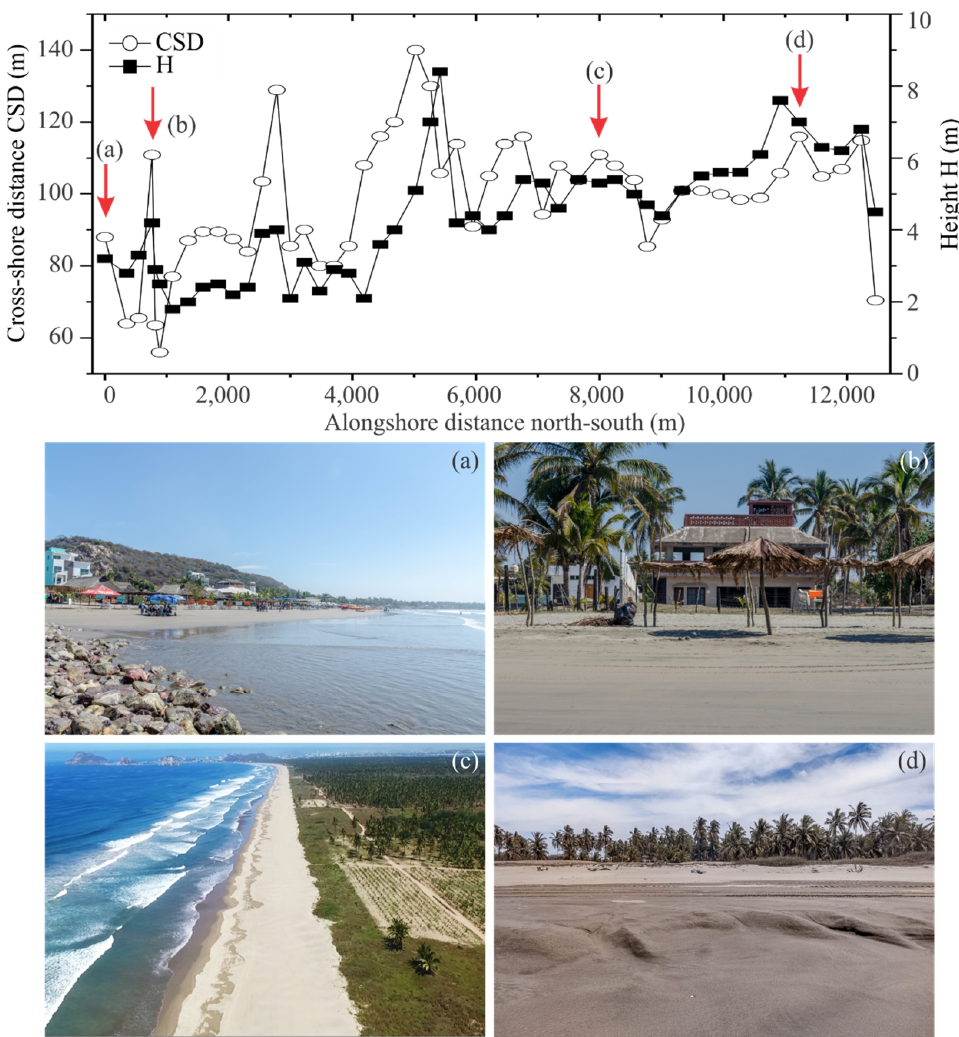
Figure 3. Field cross-shore distance and beach height along the southern section. Breakwater section in front of the harbor ( a ), one of the few structures on the beach ( b ), and the conservation area, which is unobstructed by infrastructure ( c , d ).